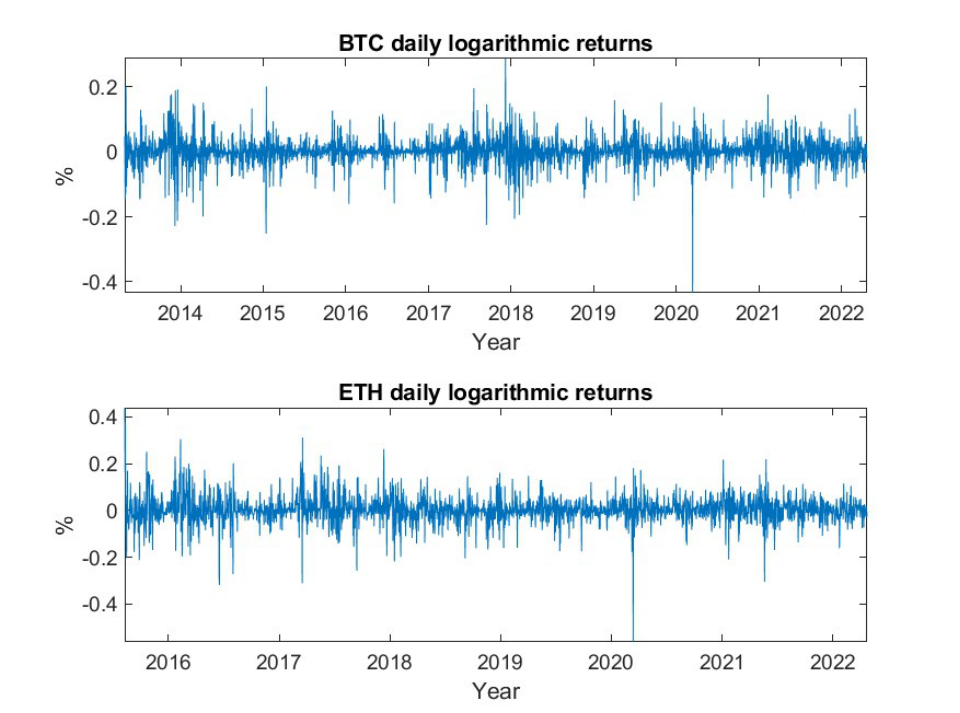
Figure 1. BTC and ETH daily logarithmic